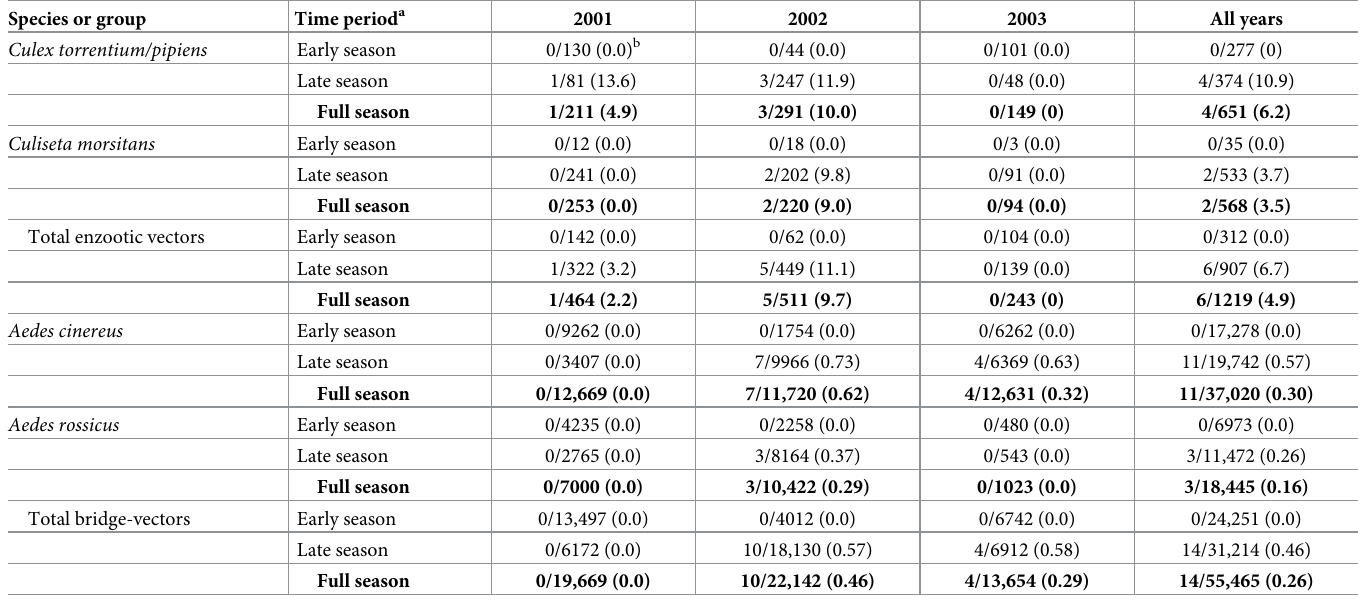
Table 2. Sindbis virus infection rates in biweekly samples of vector mosquito species collected in the River Dala¨lven floodplains, central Sweden, during 2001 until 2003. Species or